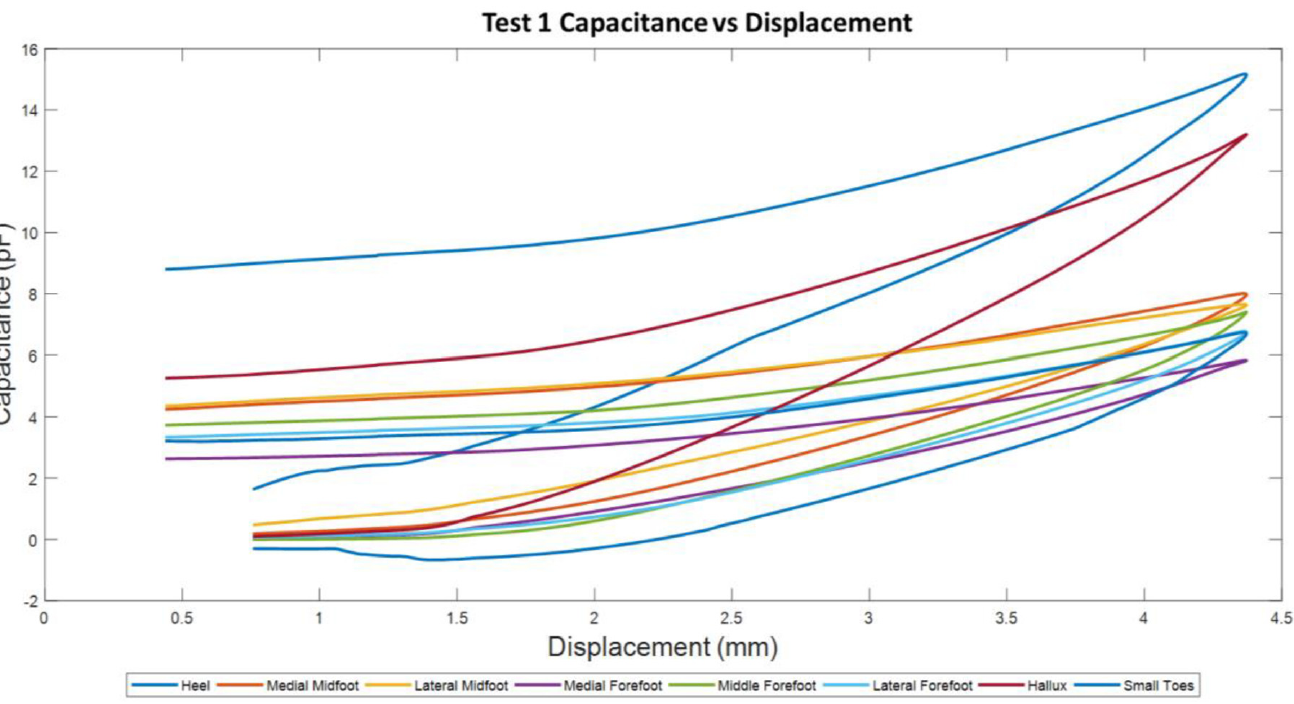
Figure 15. Test 1 Capacitance and Displacement plots for each sensor pad.